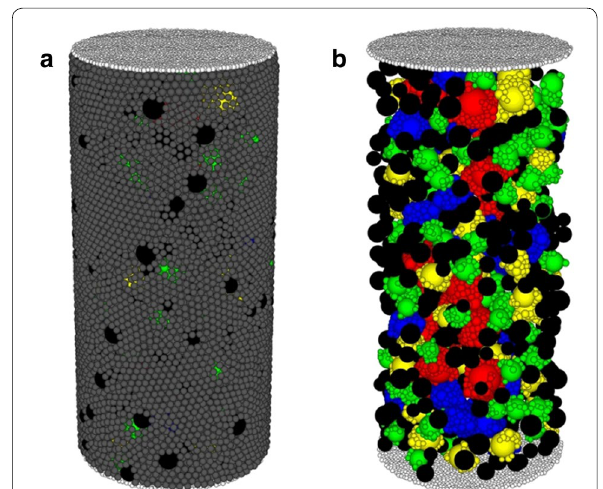
Fig. 3 The final model and its aggregate distribution map. a Final model, b aggregate distribution map.